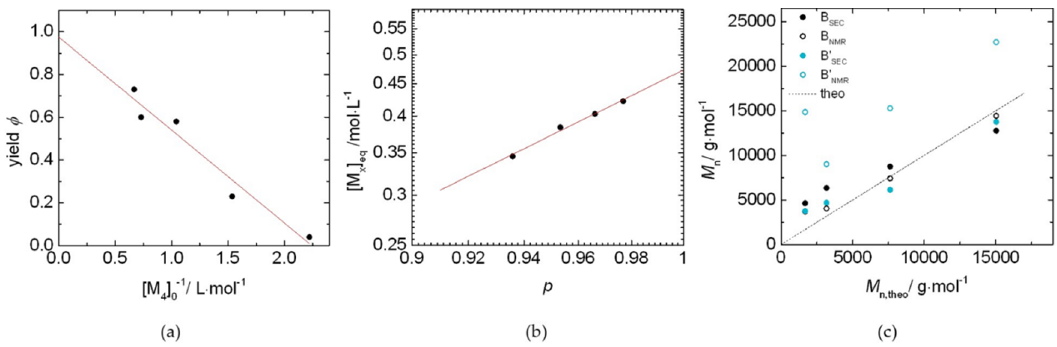
Figure 1. ( a ) Yield Φ as a function of the reciprocal monomer concentration for the ROP of M 4 in toluene with NeOH as initiator and P 4 ‐ t ‐ Bu as catalyst for different monomer concentrations ([M 4 ] 0 and constant monomer ‐ to ‐ initiator ratio n M / n I = 25. ( b ) Double logarithmic plot of the ring concentration [M x ] eq over the extent of active groups 𝑝 with linear fit function (red line) for the ROP of M 4 in toluene ([M 4 ] 0 = 0.96 mol ∙ L − 1 ), NeOH as initiator and P 4 ‐ t ‐ Bu as catalyst. ( c ) Molar mass M n (obtained by SEC and 1 H ‐ NMR) as a function of M n,theo for the ROP of M 4 in toluene ([M 4 ] 0 = 0.96 mol ∙ L − 1 ) with NeOH as initiator and two different catalysts (B: P 4 ‐ t ‐ Bu and B’: P 2 ‐ t ‐ Bu).